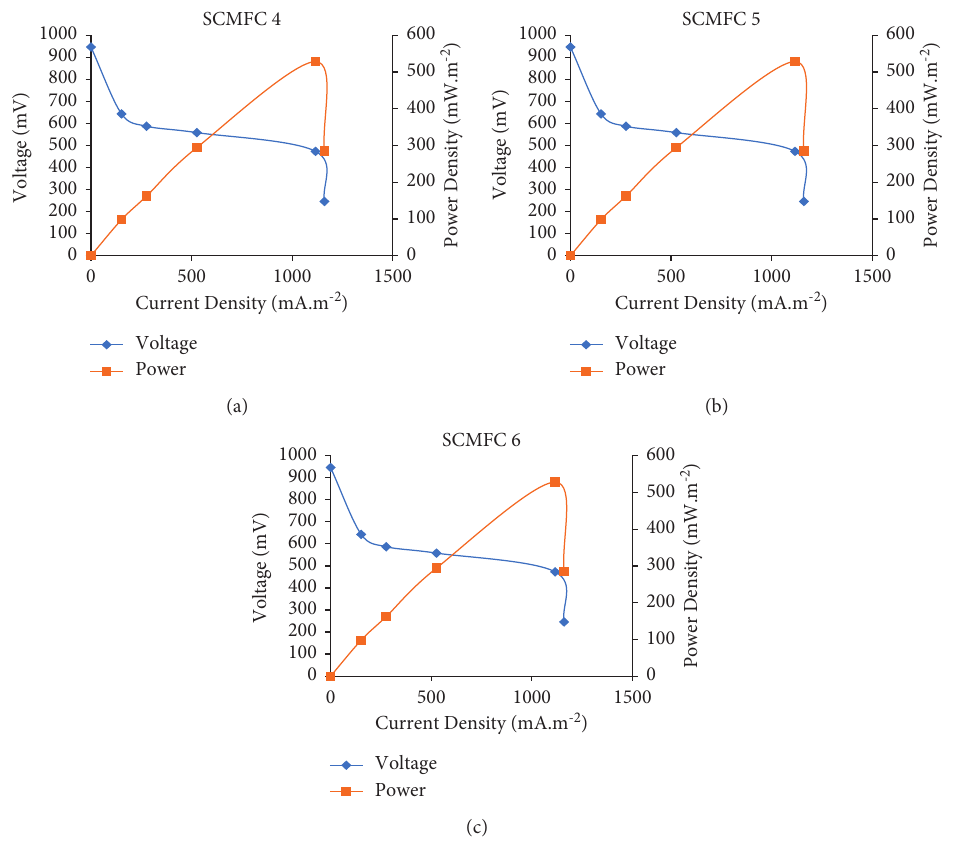
Figure 5: Polarization curves of (a) SCMFC4, (b) SCMFC5, and (c)